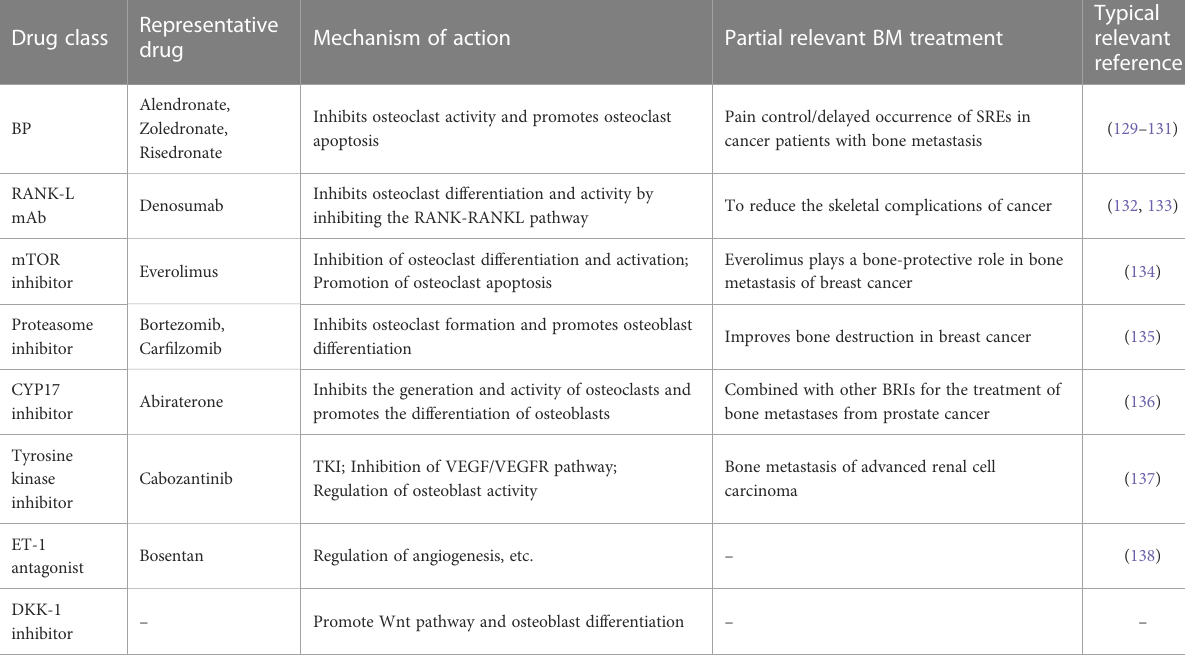
Table 3. The positive effect of bone-targeting drugs in bone metastases con fi rms the necessary for their use in patients.